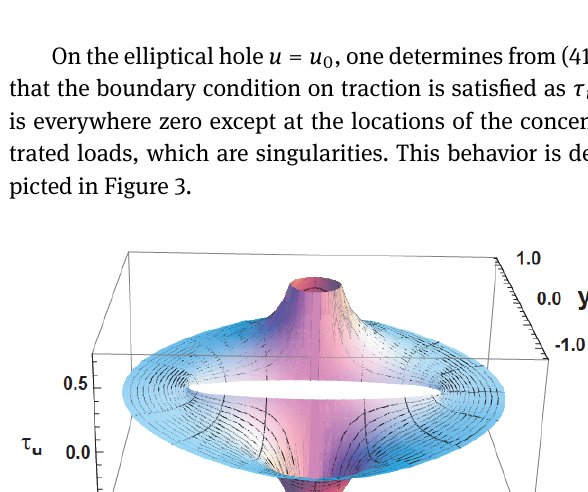
Figure 2: Stress function for elliptical hole